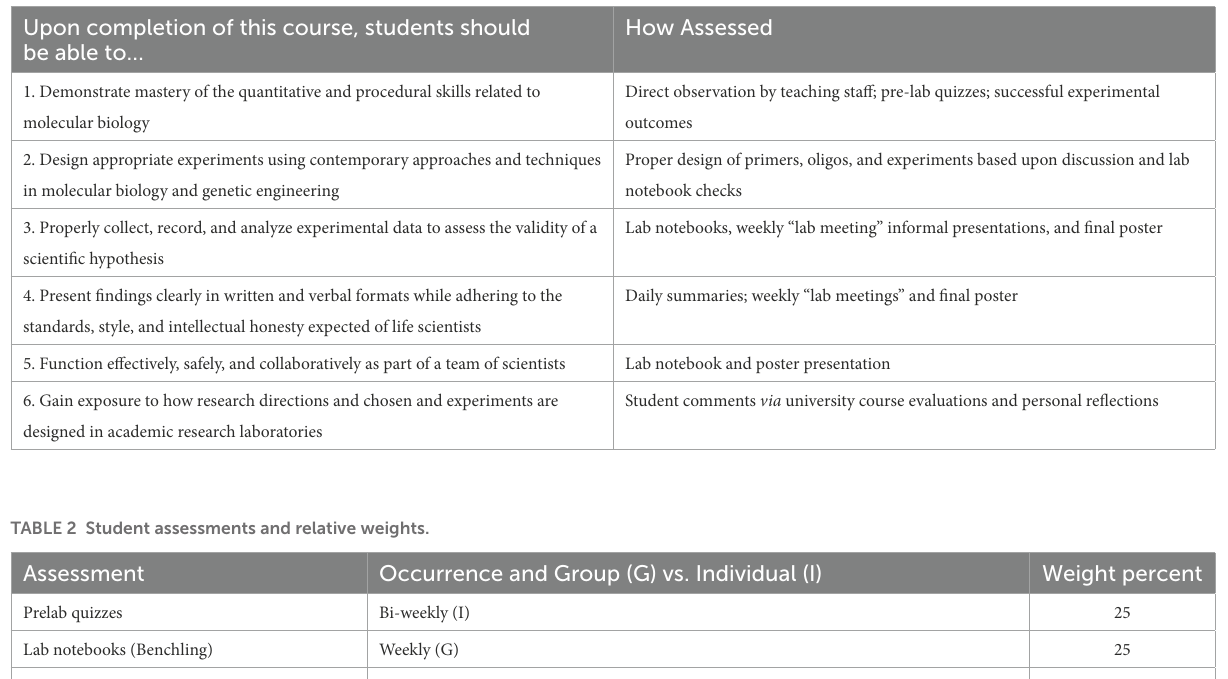
TABLE 1 Learning outcomes mapped to student assessments.